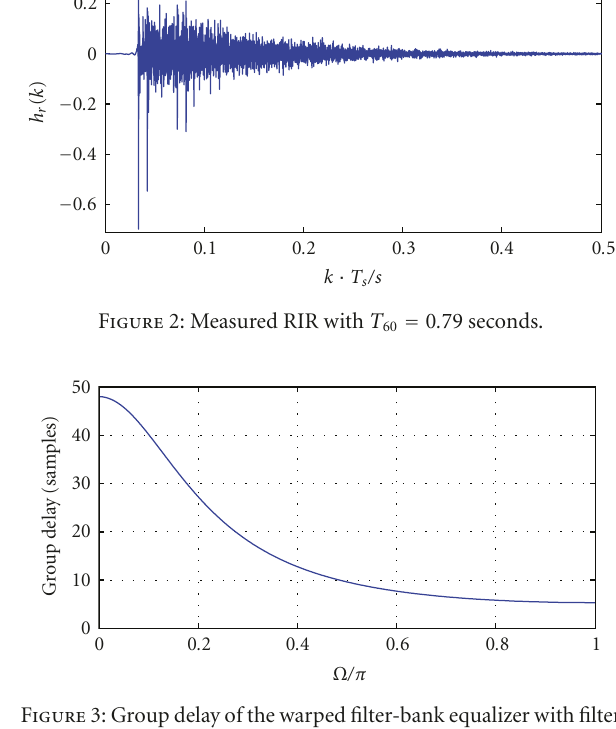
Figure 3: Group delay of the warped filter-bank equalizer with filter degree L = 32 and allpass coe ffi cient α = 0 .